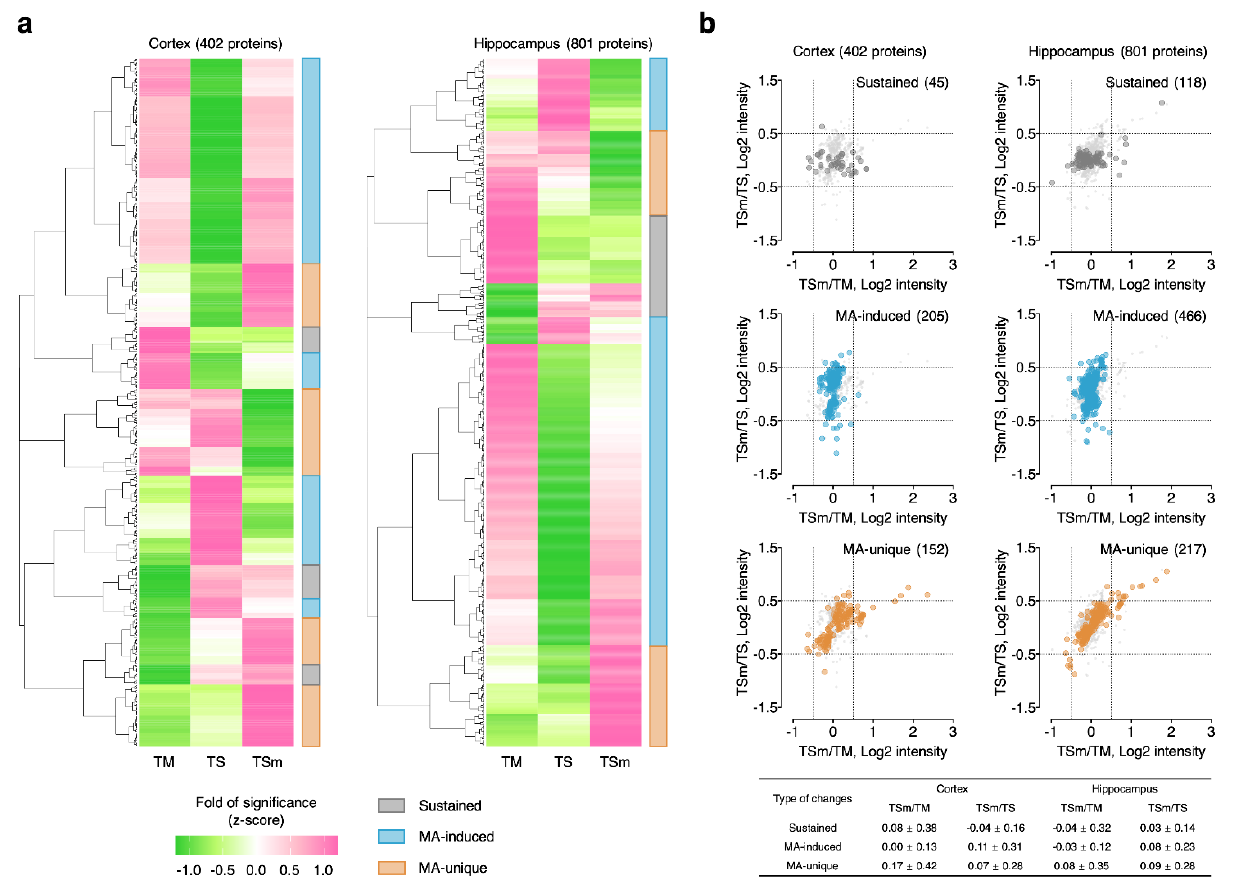
Figure 3. Classification of APs into different groups with hierarchical clustering. ( a ) Heatmaps of hierarchical clustering results. APs were classified into sustained APs, MA-induced APs, and MA-unique APs based on fold of significance, a combined score of protein fold change and p -value; ( b ) validation of AP classification results by correlation of TSm/TM and TSm/TS ratios.